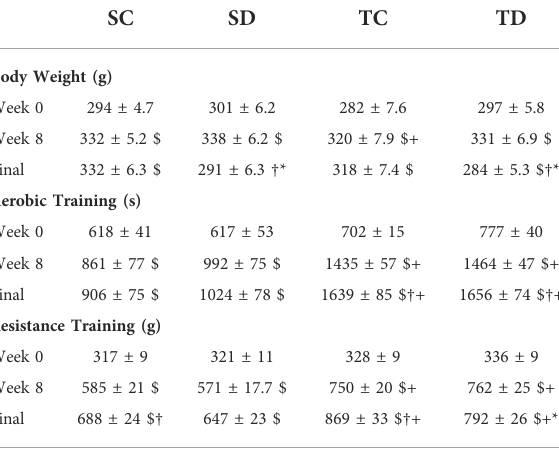
TABLE 2 Parameters of Body Weight and Physical Capacity during combined training and DEX treatment in all SHR